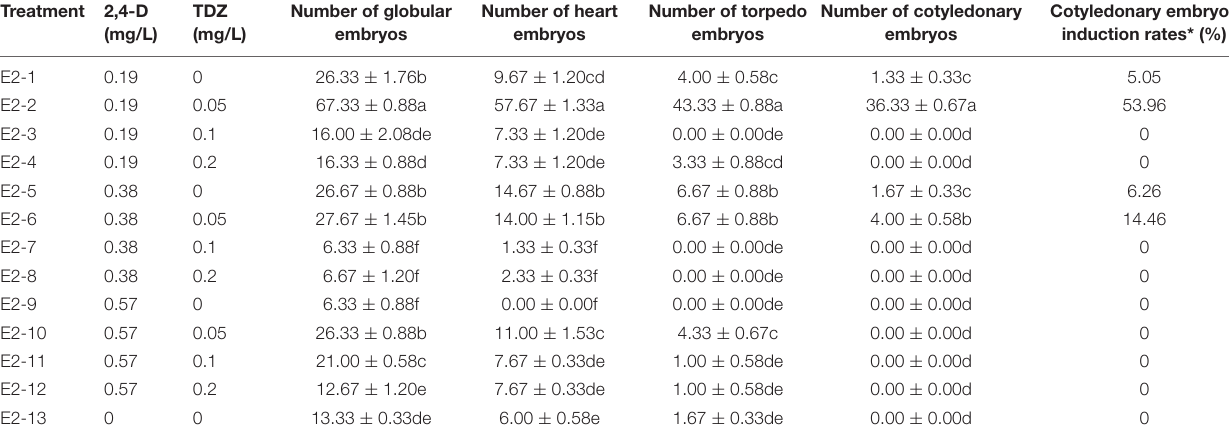
TABLE 4 | Direct somatic embryogenesis and differentiation from COT with the combination of 2,4-D and TDZ in C. oleifera . Treatment 2,4-D